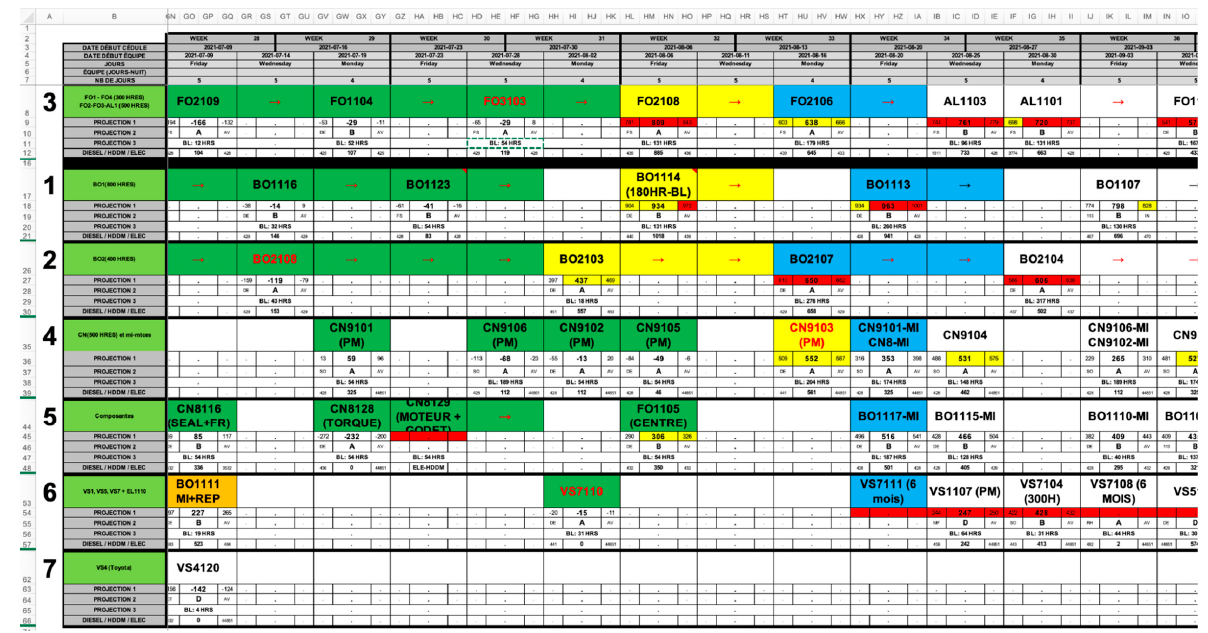
Figure A2. GuideTi example work order.